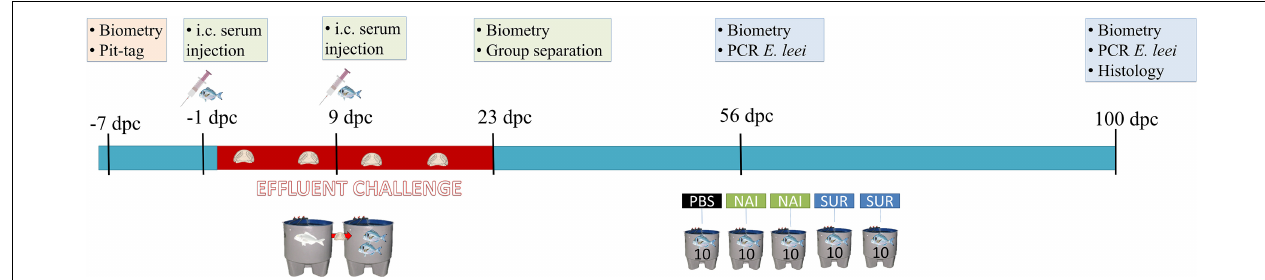
FIGURE 1 | Schematic representation of the passive immunization trial. Seven days before the challenge by effluent exposure, fish were tagged, weighted, measured and allocated together in the same tank. One day before the challenge and nine days post-challenge (dpc) fish were injected with the different sera or PBS. At 23 dpc, the effluent challenge was terminated and fish were separated in three different tanks (10 fish/tank, SUR, NAI, and PBS injected groups). At 56 dpc, a non-lethal diagnosis of the parasite by PCR was performed, and at 100 dpc all fish were sacrificed and samples for histology and diagnosis were collected. i.c.,